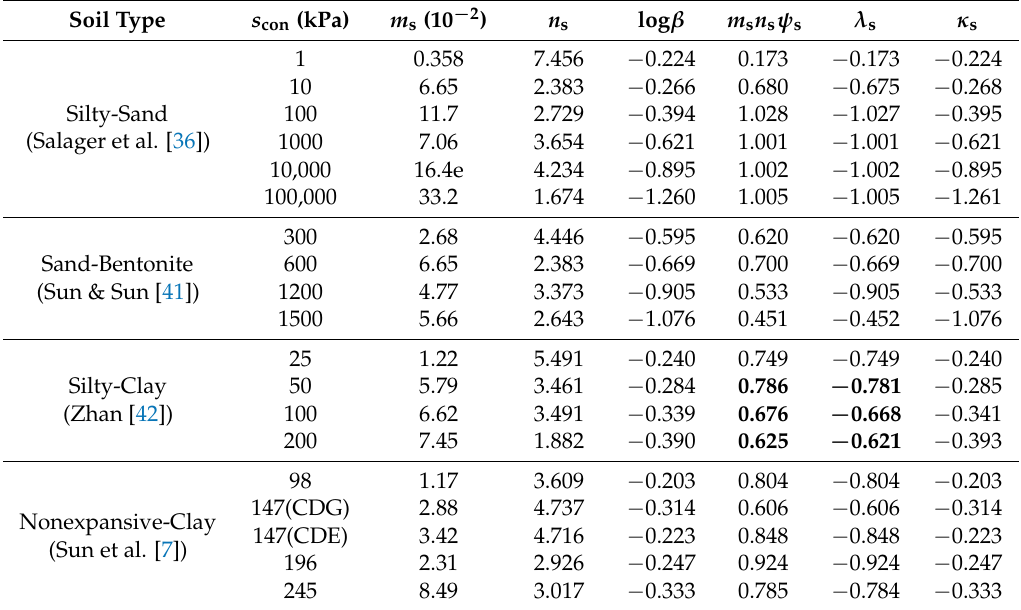
Table 3. Values of the parameters at different values of constant